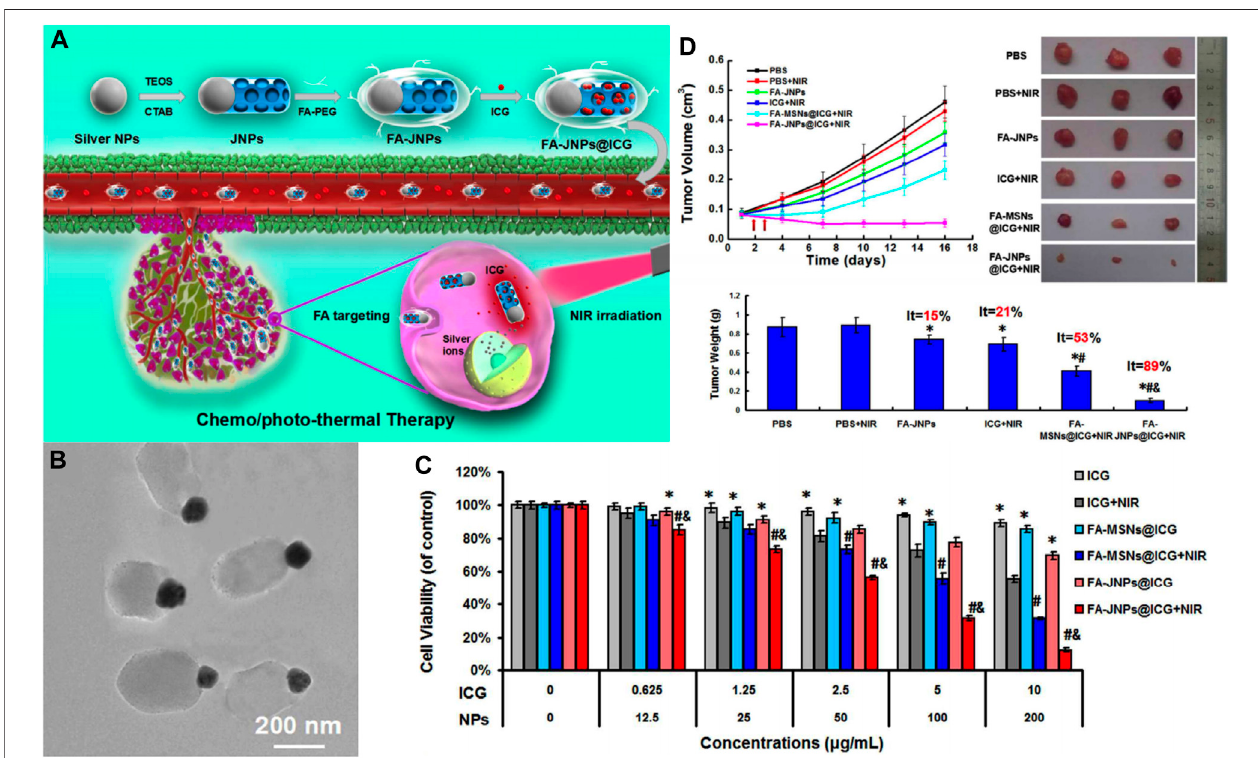
FIGURE6|(A) SchematicillustrationoftheFA-targetedJanusnanoplatformwiththeNIRirradiation-triggeredreleasebehaviorofICGandsilverionsforsynergistic liver cancer chemo/photothermal therapy. (B) TEM images of the FA-JNPs. (C) Cells viability of SMMC-7721 cells incubated with various concentrations of ICG, FA- MSNs@ICG, or FA-JNPs@ICG with or without NIR irradiation for 24 h (808 nm, 1 W cm − 2 , 5 min). (D) In vivo tumor inhibition evaluation of the chemo/photothermal therapy. Reprinted with permission from Wang et al. (2017c). Copyright (2017) American Chemical